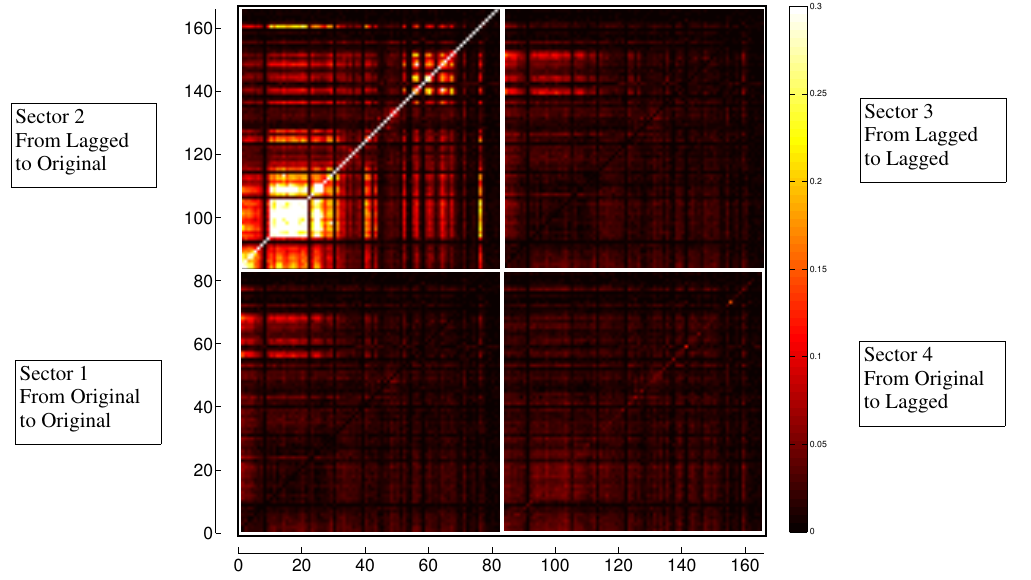
Figure 4. Effective Transfer Entropy (ETE) matrix. Brighter areas correspond to large values of ETE, and darker areas correspond to low values of